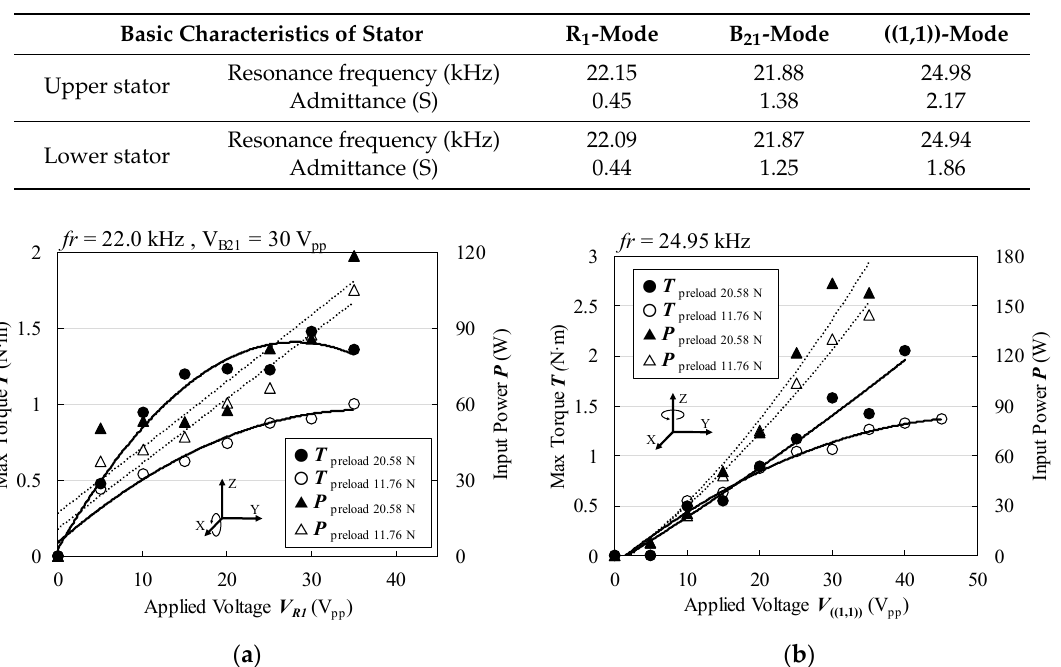
Figure 15. Maximum torque and electric input power with respect to applied voltage. ( a ) Rotation around X(Y)-axis and ( b ) Rotation around Z-axis. Table 3. Basic characteristics of stators with support ring attached.